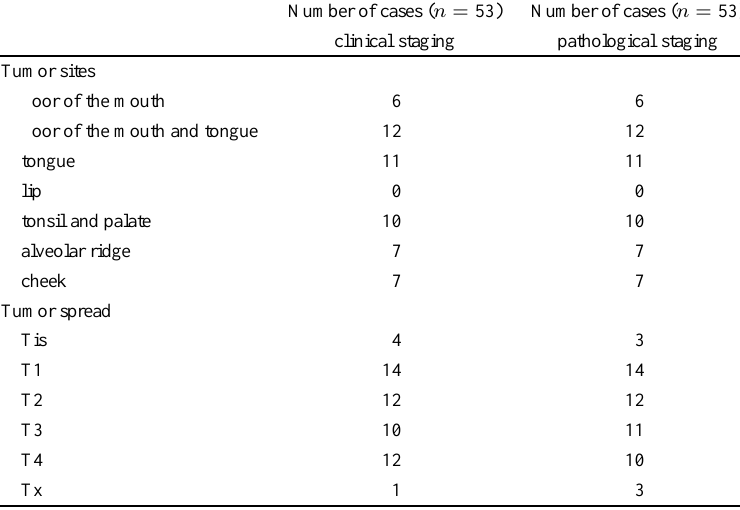
Synopsis about tumor site and tumor spread of 53 patients with squamous cell carcinoma of the oral cavity Number of cases ( n =